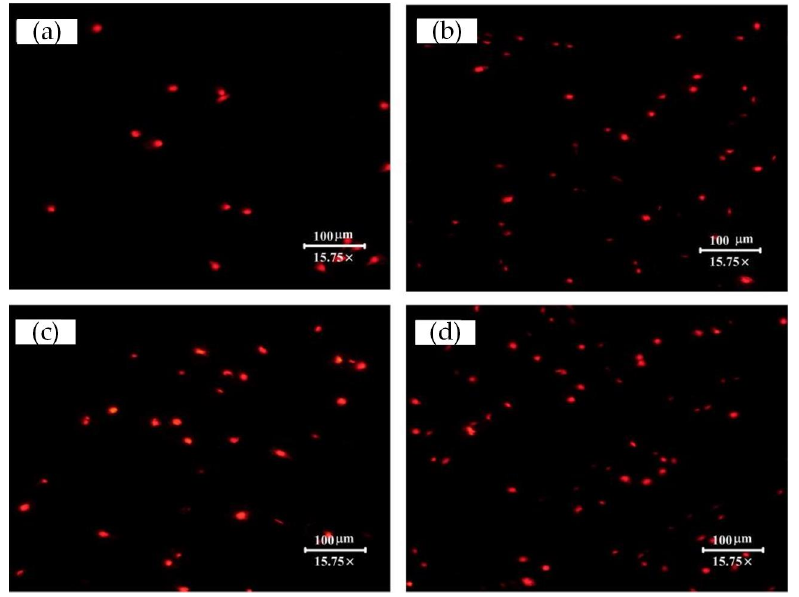
Figure 7. Stereo fluorescence microscope pictures taken for MC3T3-E1 cells adherent on the different surfaces after culturing for 3 h presented the variation in cell density and cell numbers: ( a ) Smooth; ( b ) Texture 1; ( c ) Texture 2; and ( d ) Texture 3.